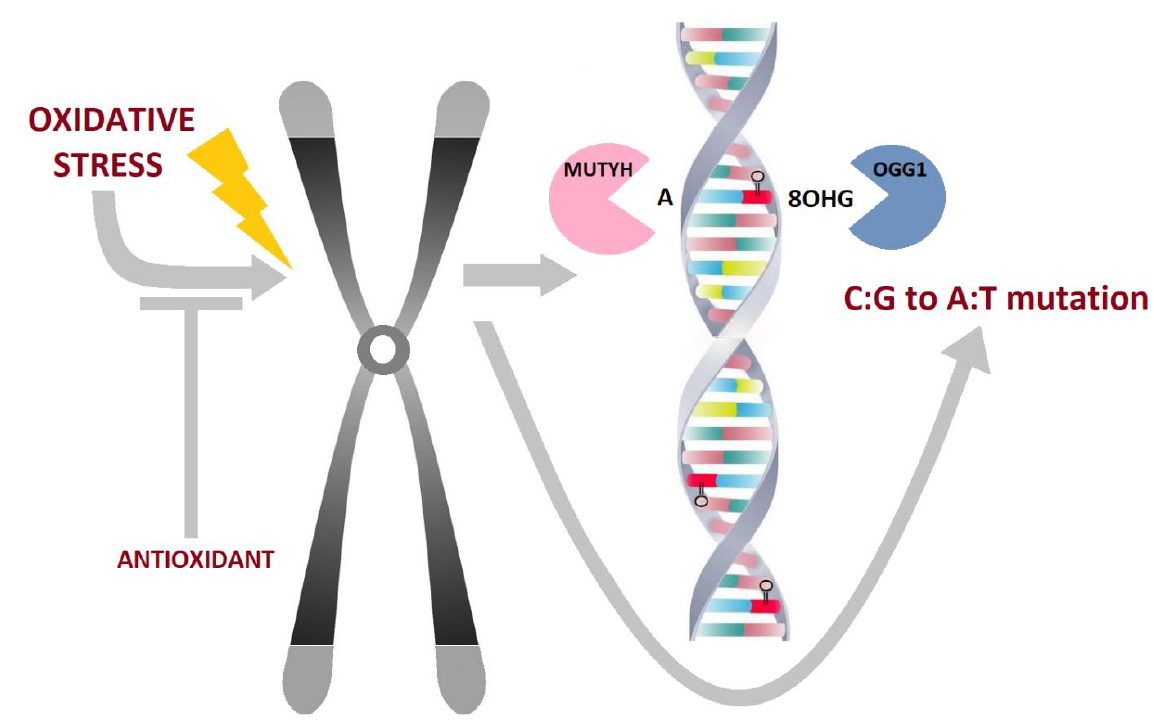
Figure 1. MUTYH and hOOG1 cooperate to prevent C:G to A:T transversion mutations under oxidative stress.